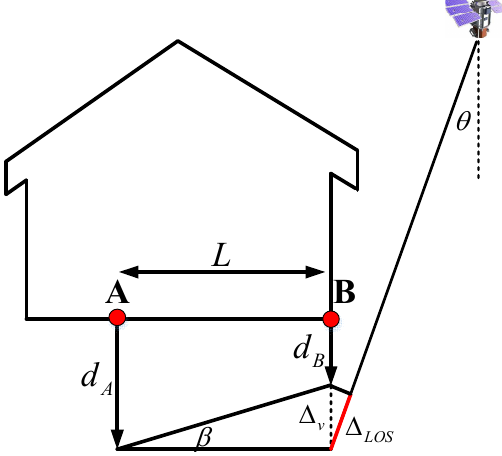
Figure 2. Schematic representation of differential settlement parameters used within the analysis. In the picture, d A and d B are the settlement of the two points (A and B) respectively.